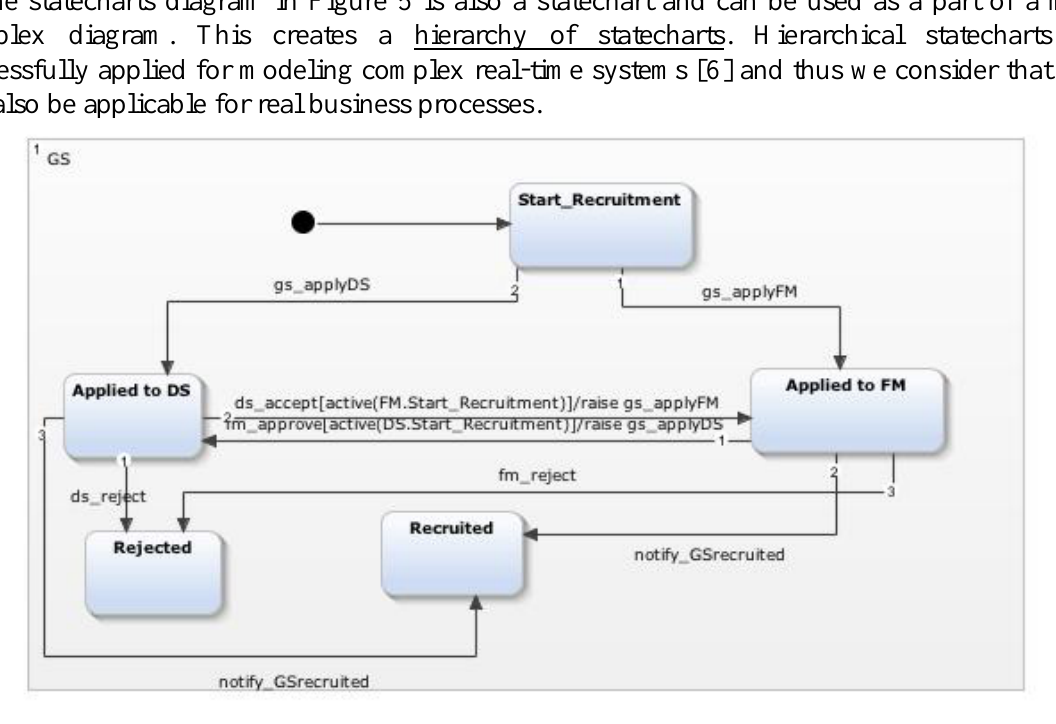
Figure 1. Statecharts model of behavior of the Graduate Student (GS) within the formal PhD recruitment process defined by the University